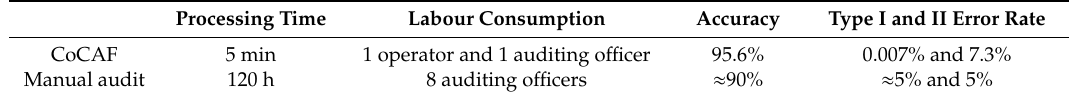
Table 2. E ff ectiveness confusion matrix for